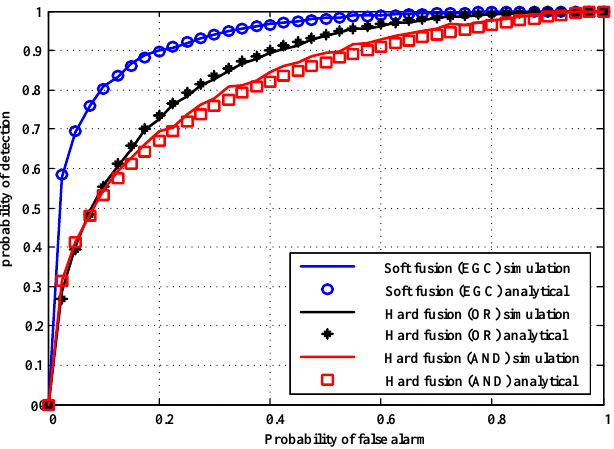
Figure 2. Probability of detection versus probability of false alarm of soft and hard fusion rules.